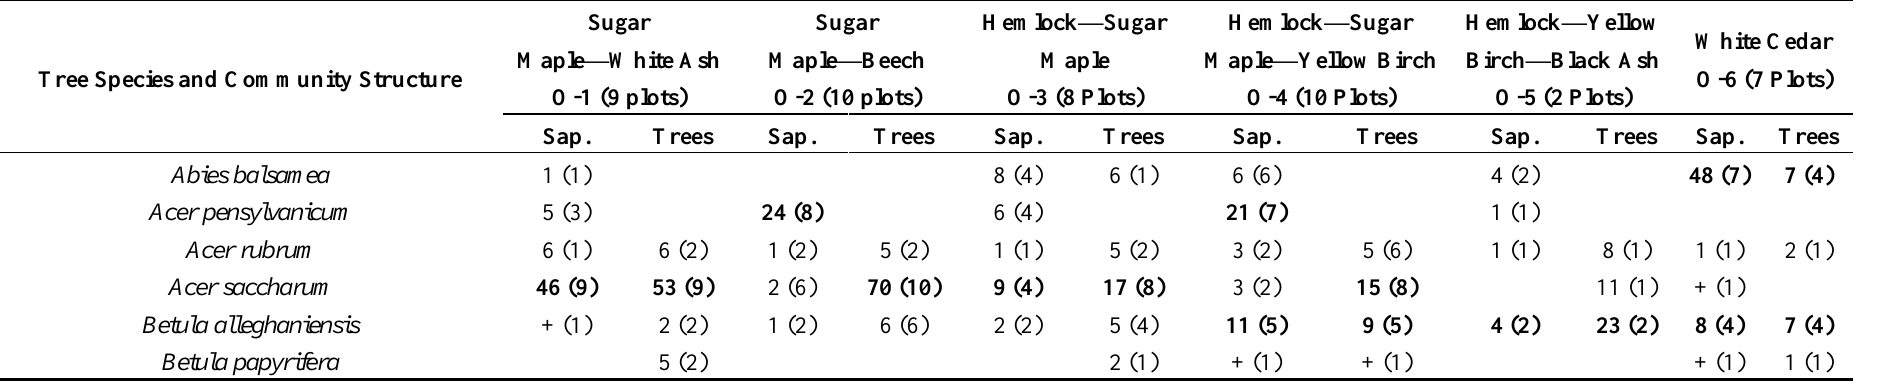
Table 2. Relative density of large saplings (5–10 cm DBH; Sap. in table) and relative basal area of large trees (>20 cm DBH; Trees in table) of the Old Forests community types of the St-Benoît-du-Lac Abbey forested areas. Means of large sapling density, tree (>10 cm DBH) density, large tree basal area, and total basal area (saplings + trees) for each community type are indicated at the bottom of the table. The number of plots in which saplings and trees of each species were recorded is given in brackets in the table. Tree Species and Community Structure